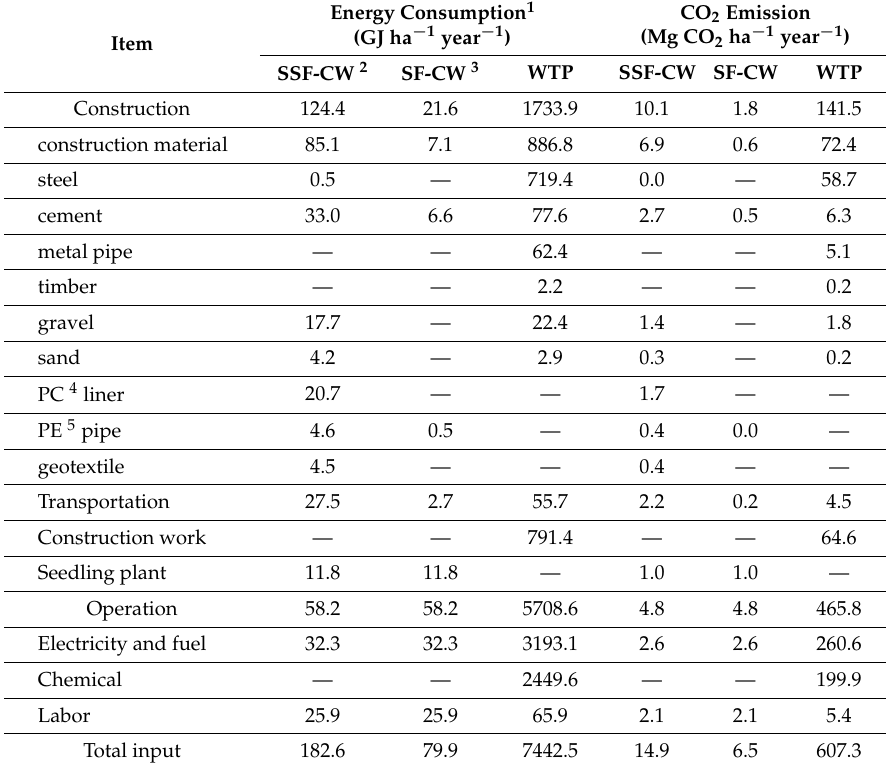
Table 4. Energy consumption (unit: GJ ha − 1 year − 1 ) and CO 2 emission (unit: Mg CO 2 ha − 1 year − 1 ) of total input for the WTP and the CW for wastewater